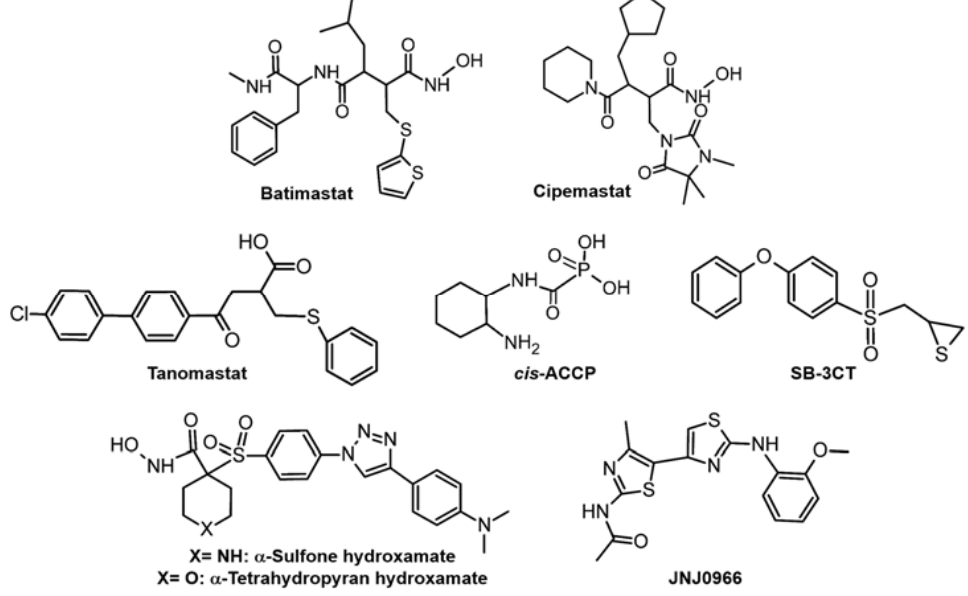
Figure 1. ZBG-based regulators and non-ZBG-based regulators targeting catalytic domain and Figure 1. ZBG ‐ based regulators and non ‐ ZBG ‐ based regulators targeting catalytic domain and exo ‐ exosite-targeted site ‐ targeted regulator.